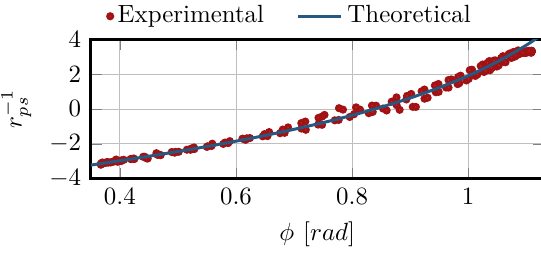
Figure 19. Inverse transmission ratio of the